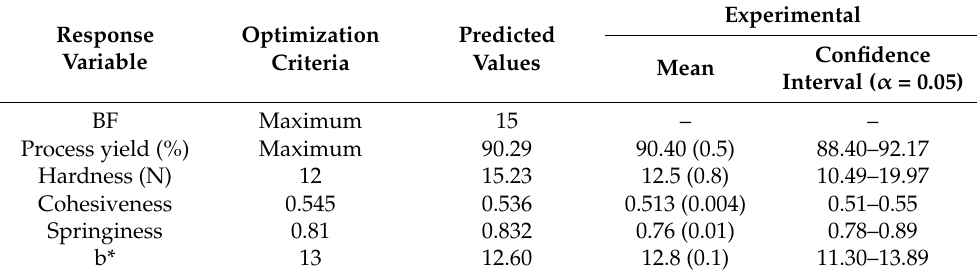
Table 3. Optimization criteria and predicted and experimental values of process yield, hardness, cohesiveness, springiness, and yellowness (b*) obtained for the optimized BF-burger. Experimental Response Optimization Predicted Confidence Variable Criteria Values Mean Interval ( α = 0.05) Process yield